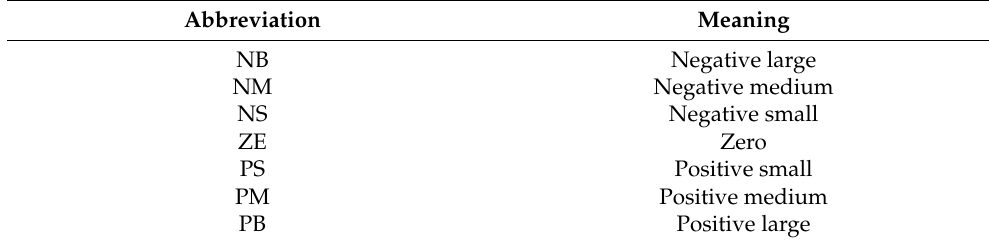
Table 1. Meanings of fuzzy subsets.